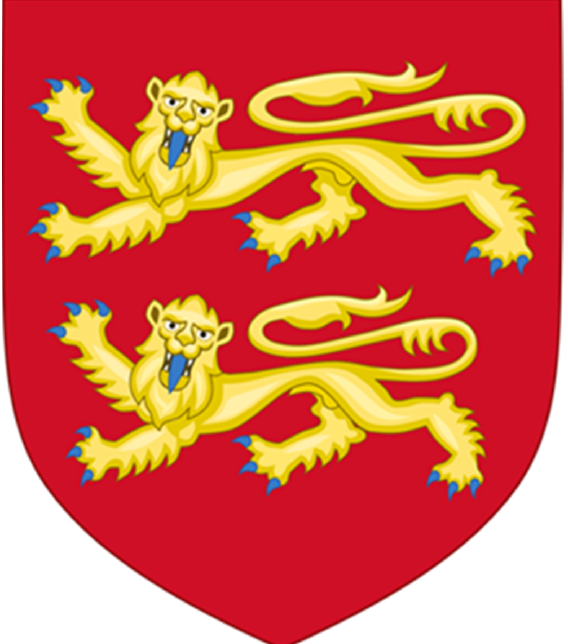
Figure 14. Heraldic Insignia of Normandy. © Sodacani, Wikimedia Commons. https://commons.wikimedia.org/w/index.php?curid=11504651 (accessed on 12 September 2021).